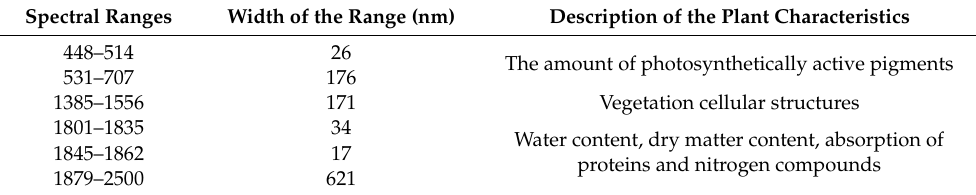
Table 2. Statistically significant spectral ranges for trampled and reference plants ( α = 0.05). Spectral Ranges Width of the Range